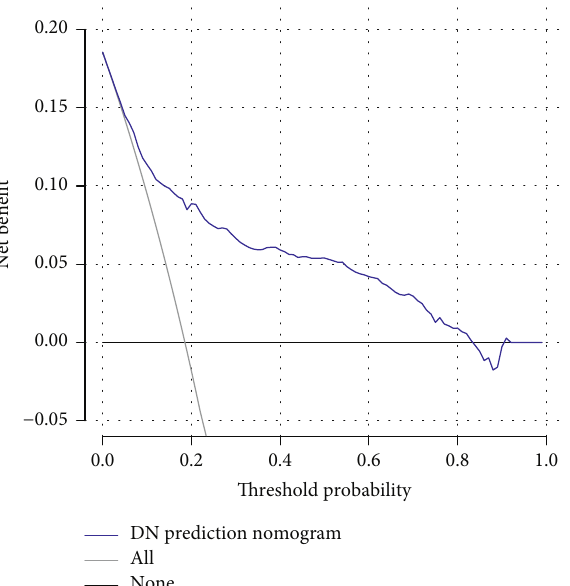
Figure 5: Decision curve analysis for the DN risk nomogram. The y -axis tested the net benefit. The thin solid line meant the assumption that all patients had DN, while the thick solid line represented the assumption that all patients had no DN. The dotted line represented the risk